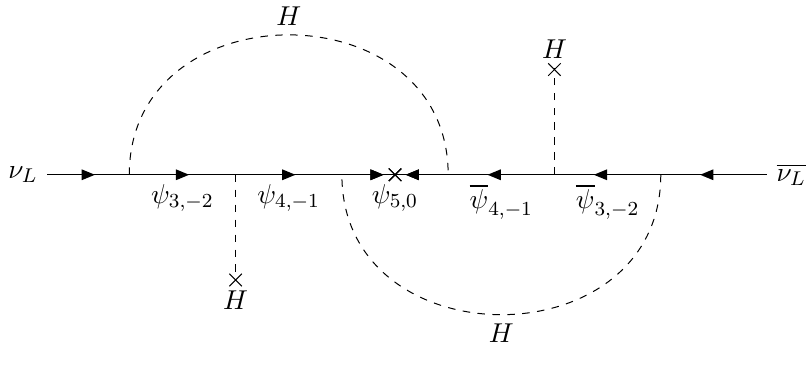
Figure 2 . One possible realisation of the Weinberg operator in the unique model with only three new fermionic representations generating neutrino mass at loop